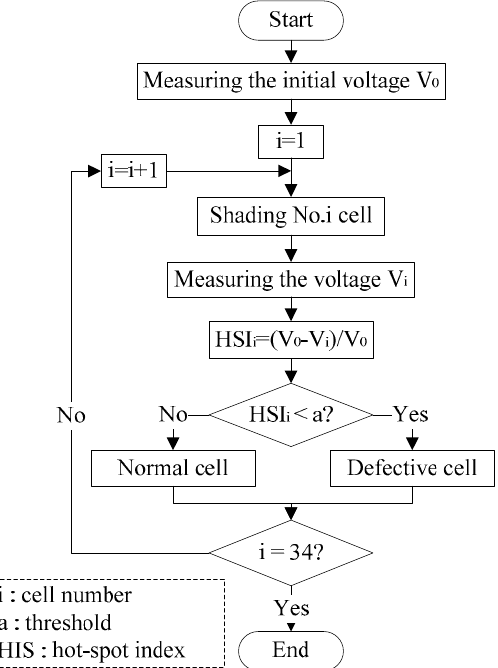
Figure 11. Detection flow chart, which determines the risk factor of each cell inside a PV module.